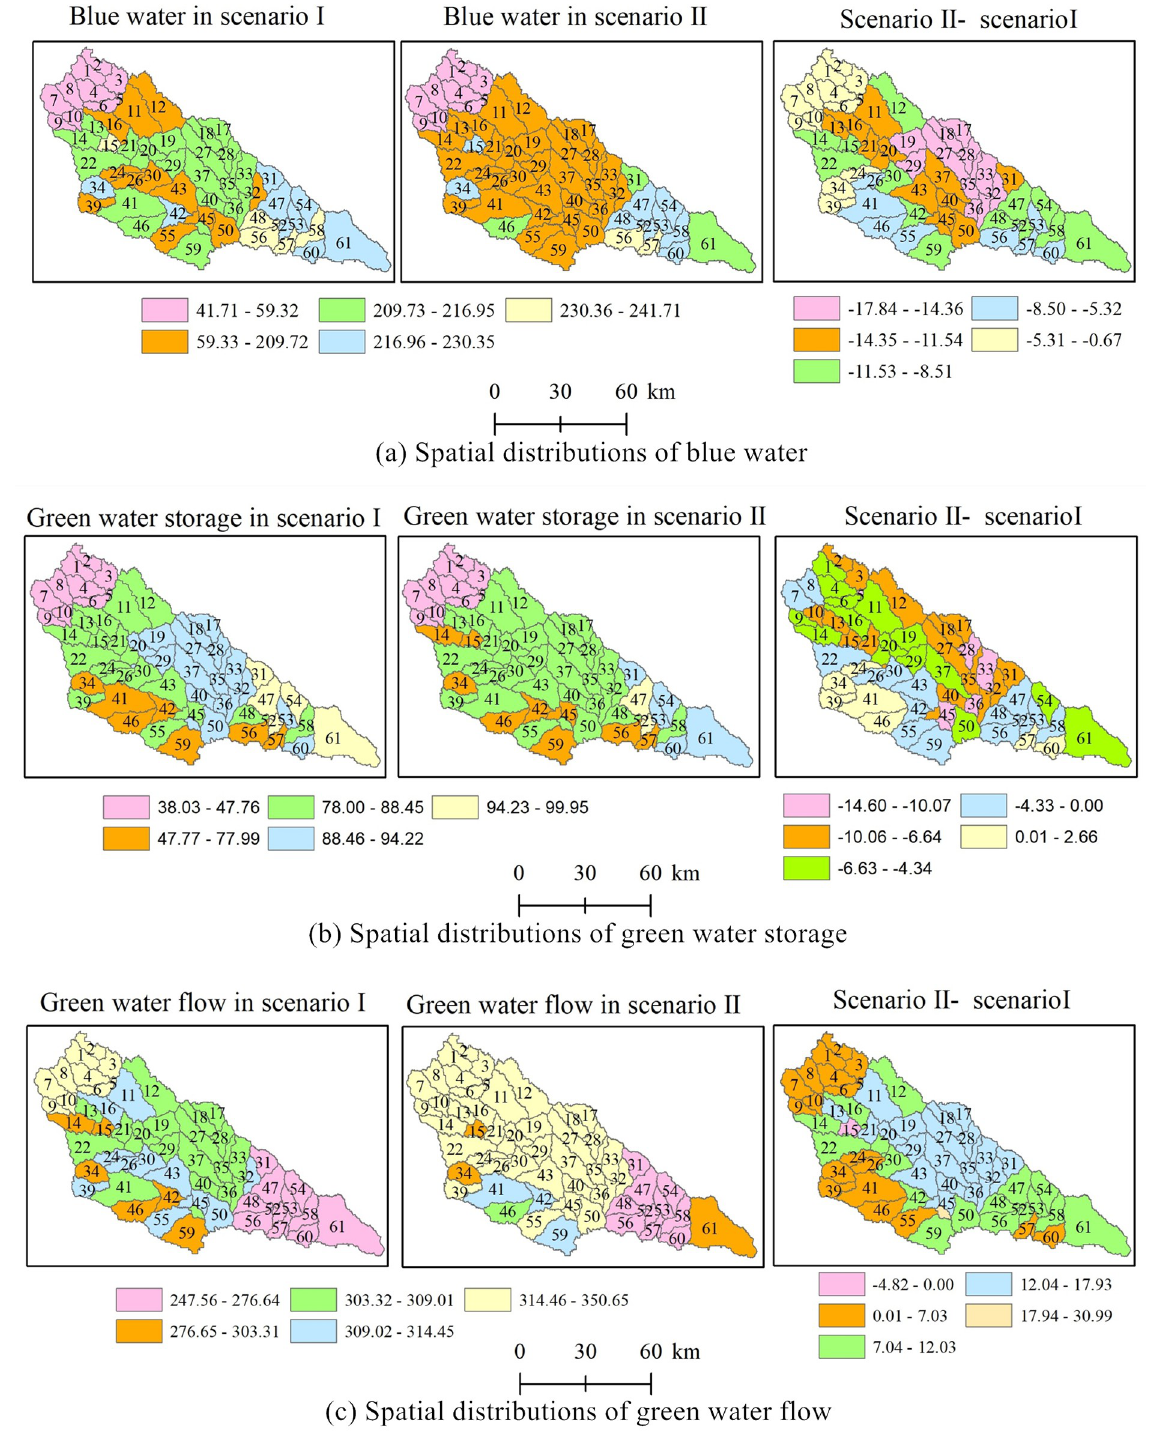
Fig 7. Spatial distributions of blue and green waters. The map was prepared in ARCGIS using sub-basin boundaries and blue/green water calculation results from the Results of watershed division on Yanhe river Basin. The spatial distribution range values of scenario 1 and scenario 2 were represented in the same color, and the spatial distribution range of their difference values was represented